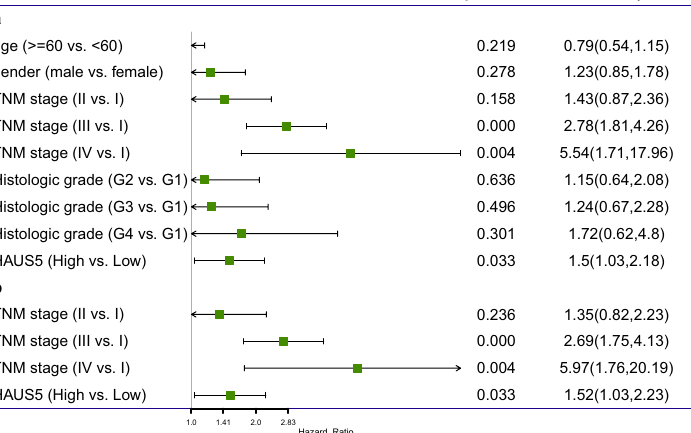
Figure 5. Univariate (a) and multivariate (b) Cox regression analyses of the correlations of HAUS5 and other clinical parameters with OS in TCGA-LIHC cohorts.